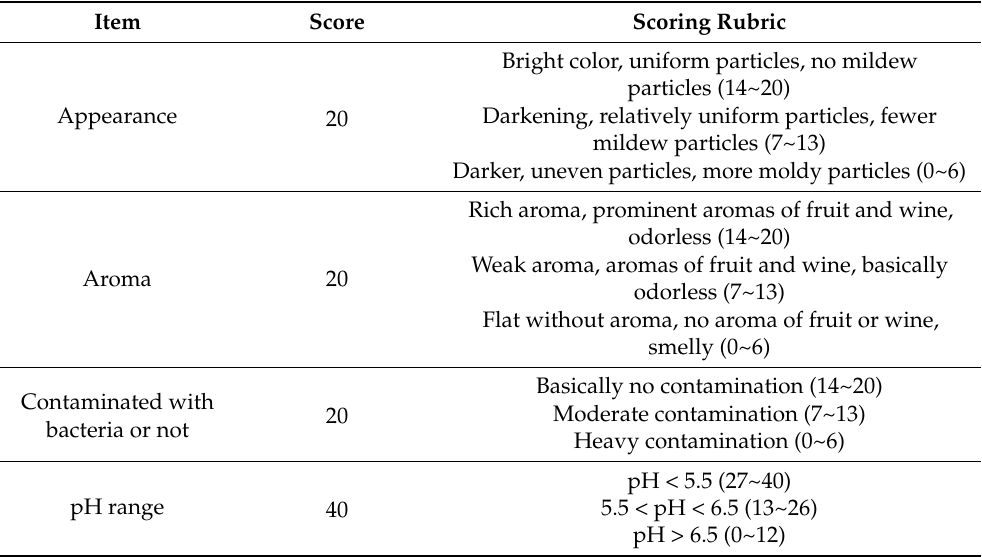
Table 1. Sensory evaluation criteria for fermentation